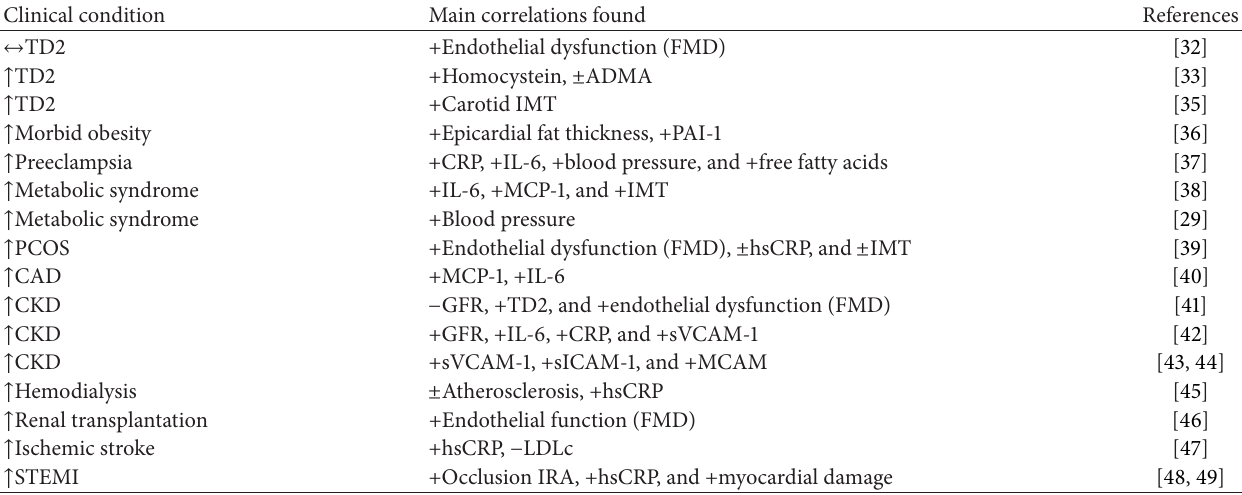
Figure 1: Diagram summarizing the main reported direct actions of visfatin/Nampt in cells in the cardiovascular system, namely, cardiac fibroblast and cardiomyocytes, mesangial cells, monocytes and macrophages, smooth muscle cells, and endothelial cells. eNOS: endothelial nitric oxide synthase, IL-8: interleukin-8, MMP-2/9: matrix metalloproteinase-2/9, NO: nitric oxide, RAS: renin-angiotensin system, and TNF- 𝛼 : tumor necrosis factor- 𝛼 . Table 1: Summary of the main correlations reported between visfatin circulating levels and CV disease in human subjects. Clinical condition Main correlations